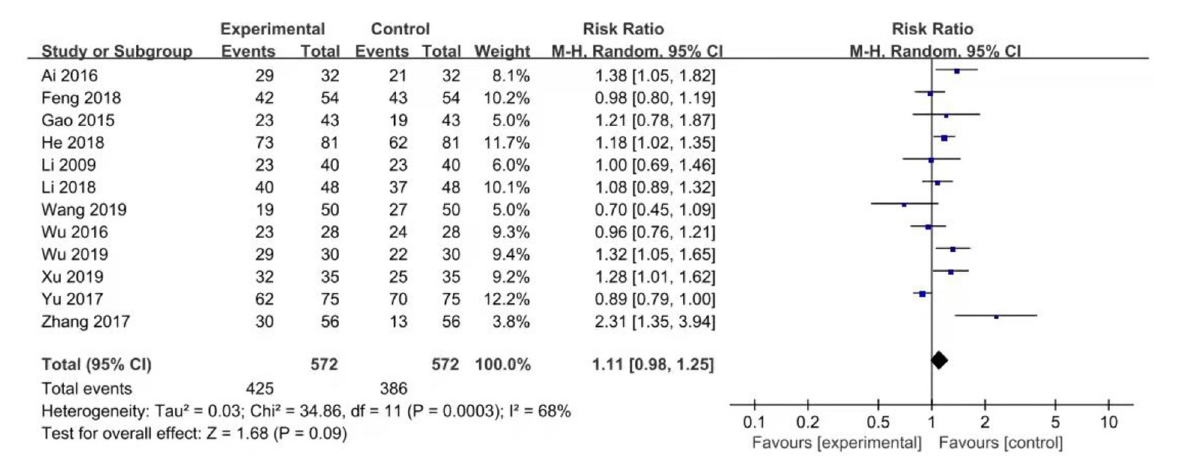
FIGURE5 Comparison of effective rate between aripiprazle group and quetiapine group. There were 12 studies that reported effective rate. The random effect model was used for analysis of effective rate due to heterogeneity ( X 2 = 34.86, df = 11, p < 0.0003, I 2 = 68%). The results showed that effective rate of aripripazole was similar to quetiapine in the treatment of bipolar depression (426/572 vs. 386/572, Z = 1.68, P =